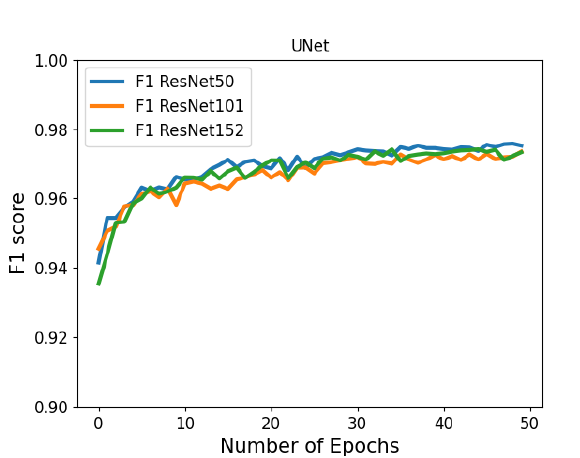
Figure 6 . F1 score for training with ResNet50(blue), ResNet101(orange) and ResNet152(green) for UNet network.